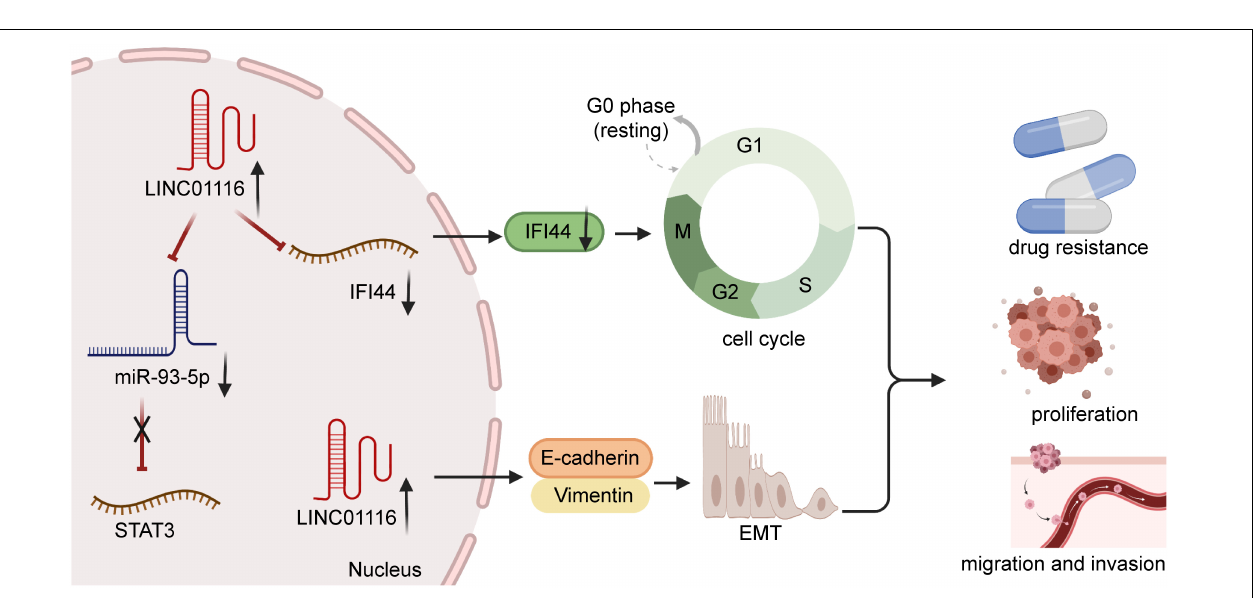
FIGURE 3 | The overexpression of LINC00261 in non-small cell lung cancer accelerates tumor progression and chemoresistance.